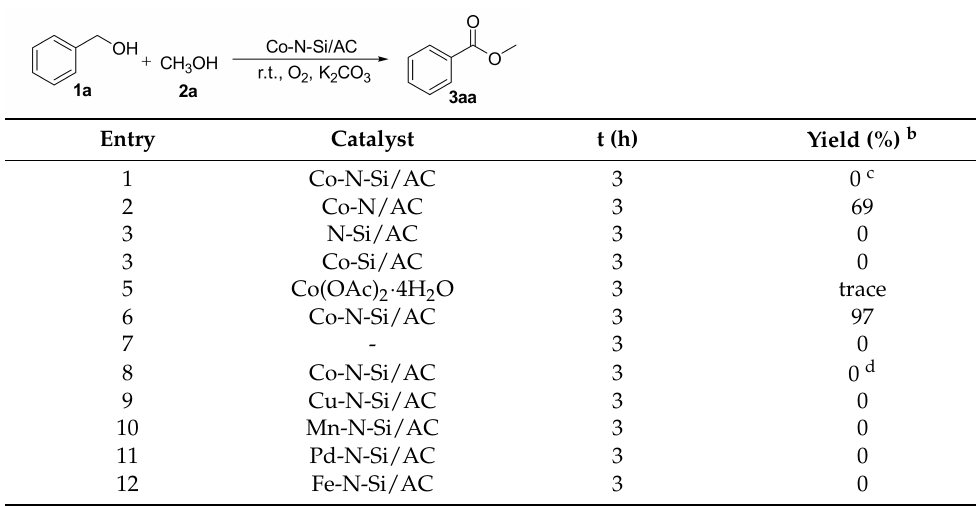
Table 1. Optimization of reaction conditions a .